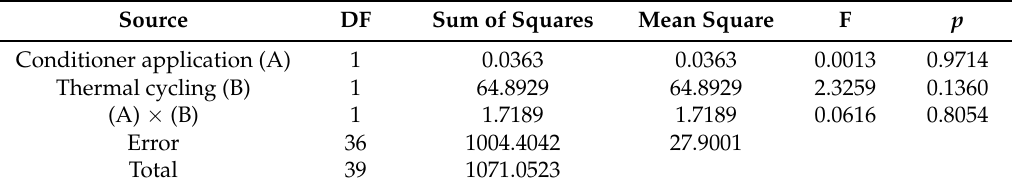
Table 2. Two-way analysis of variance (ANOVA) of shear bond strength.